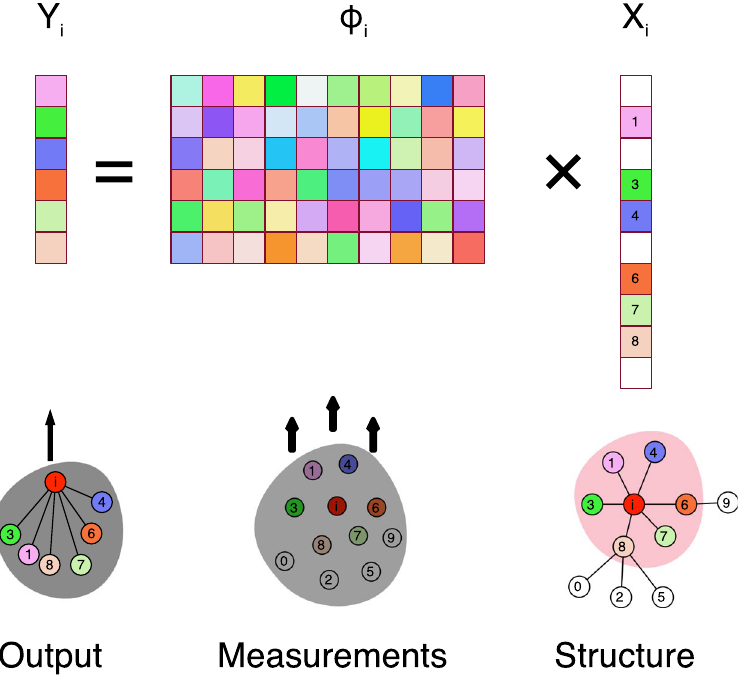
Figure 1. The network structure inference problem. The colorful squares in Y i and Φ i represent different float values. The colorful squares in X i represent the connection between vertex i and other vertices. If the square of vertex j is blank, it means that there is no connection between vertex i and j . Hence, the color of squares in X i is the same with the corresponding color of nodes in the graph. In many real world applications, the training data is insufficient, which indicates that some rows of Y i and Φ i are missing, such as the j ∈ E missing row in Y i and Φ i .